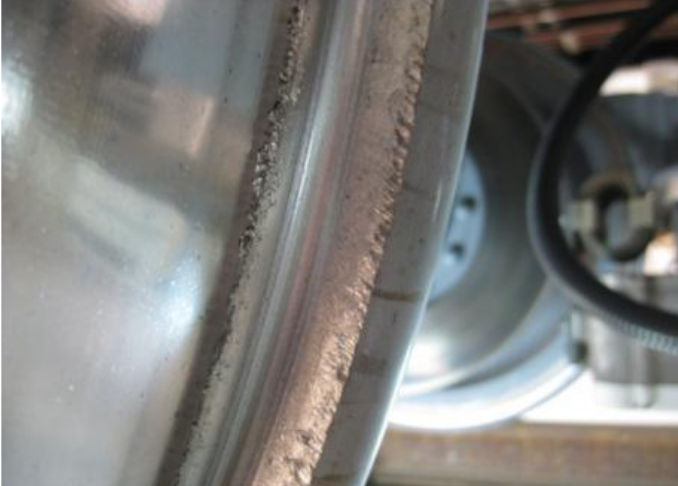
Figure 1. City train wheel experiencing severe wear.